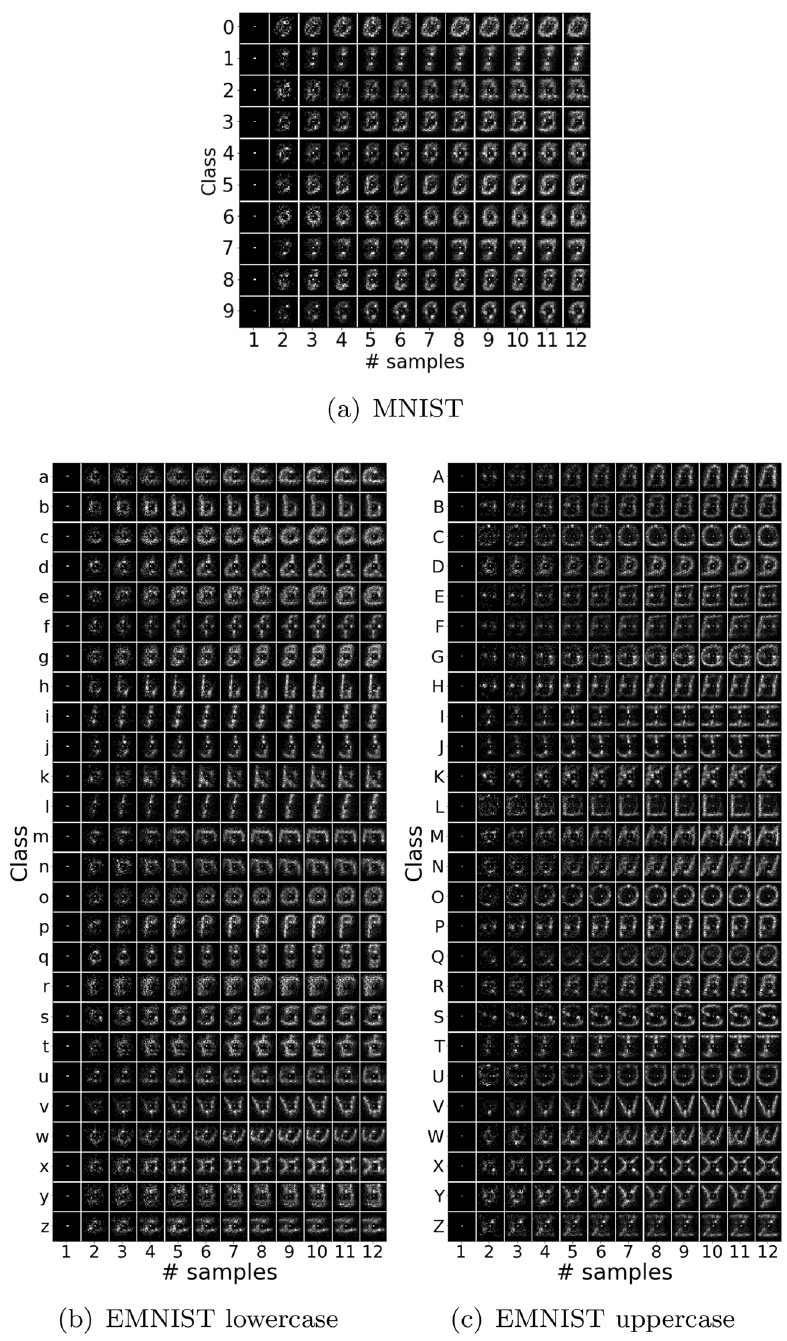
Figure 3. Distribution of sampling locations over all participants for each numeral/alphabet class and each sampling episode. Each row corresponds to a class, each column corresponds to a sampling episode which increases from left to